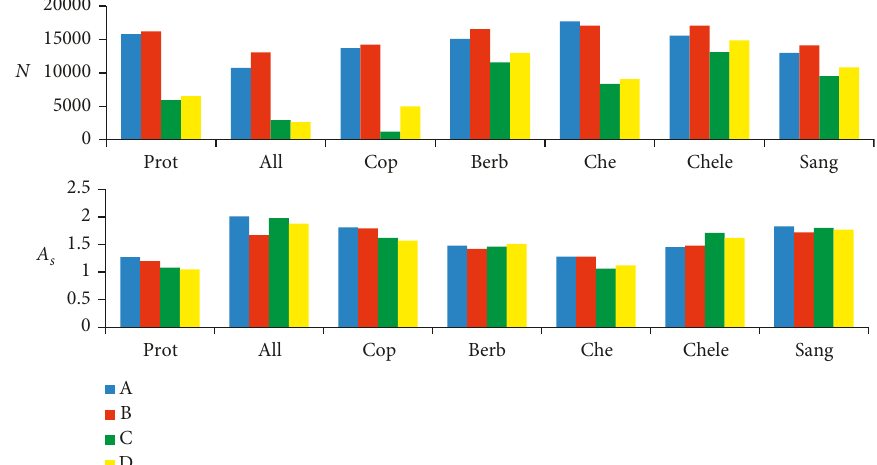
Figure 3: Comparison of theoretical plate numbers and peak asymmetry obtained on XB-C18 column for 20% of acetonitrile and 30% of methanol: (A) acetonitrile and 10 mM water solution of ammonium acetate adjusted to pH 4 with acetic acid; (B) acetonitrile and 10mM water solution of ammonium formate adjusted to pH 4 with formic acid; (C) methanol and 10mM water solution of ammonium acetate adjusted to pH 3 with acetic acid; (D) methanol and 10mM water solution of ammonium acetate adjusted to pH 4 with acetic acid.